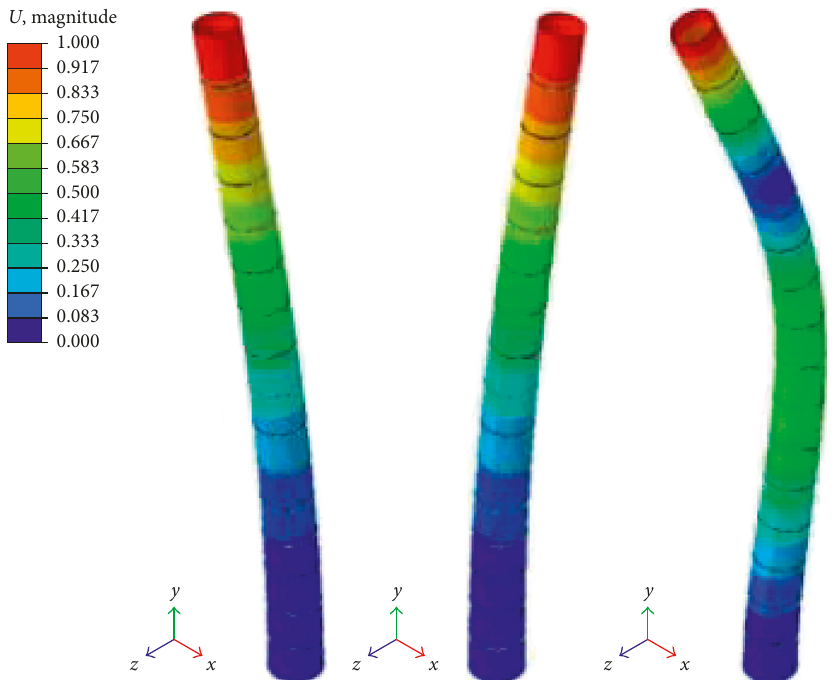
Figure 11: First three vibration modes of the wind